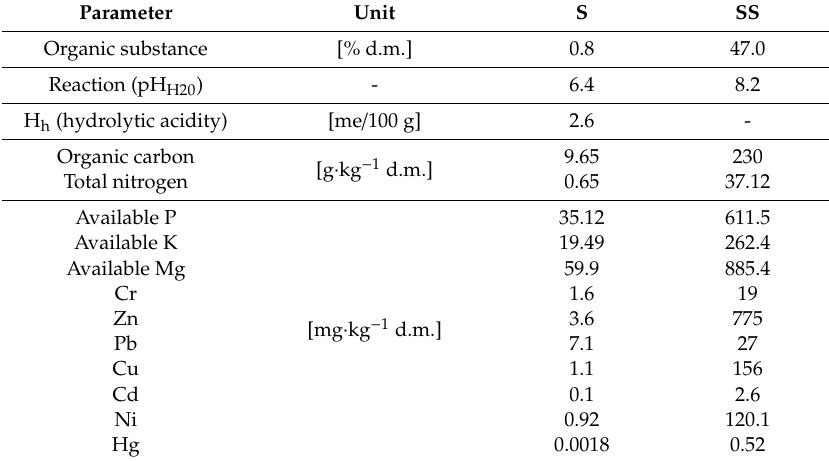
Table 1. Physical and chemical properties of soil and sewage sludge used in the lysimeter experiment.